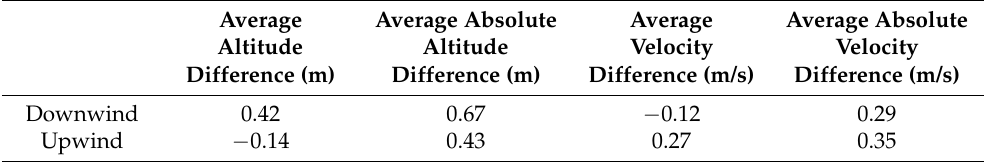
Table 5. Model predictions compared to actual values. Average